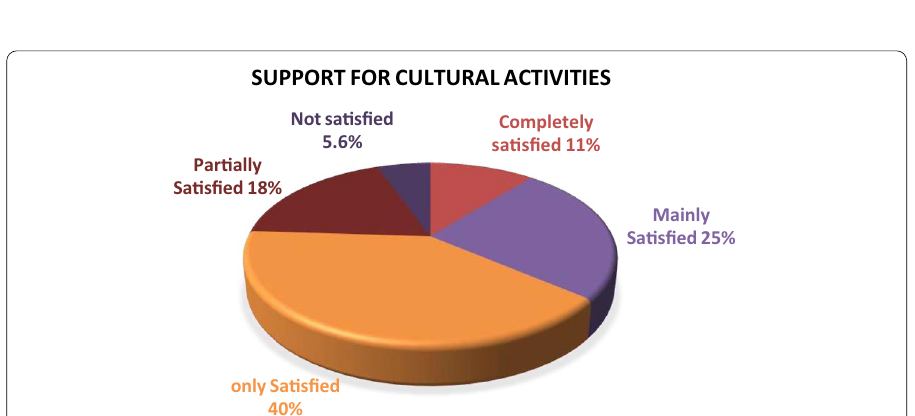
Fig. 3 Graphical representation of responses received for support provided for cultural